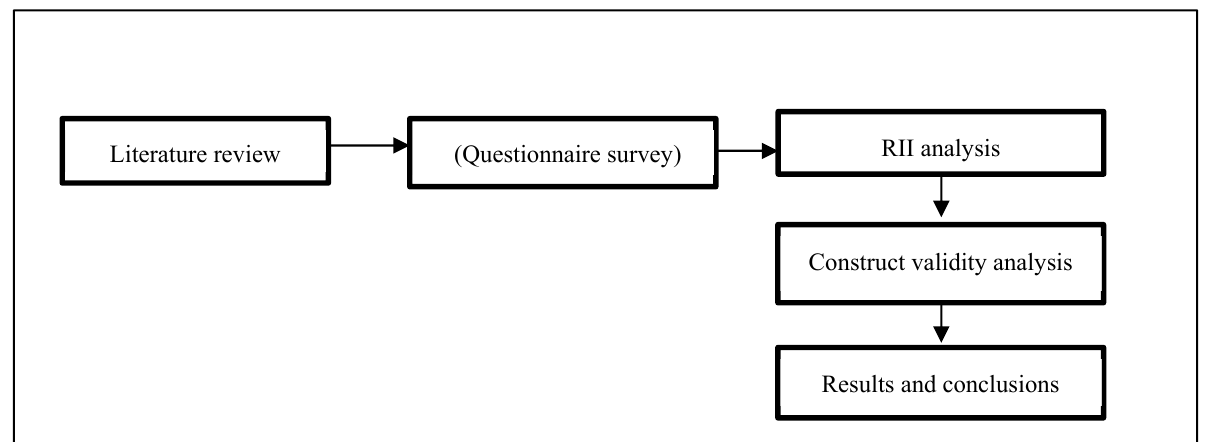
Figure 1. Research flowchart .